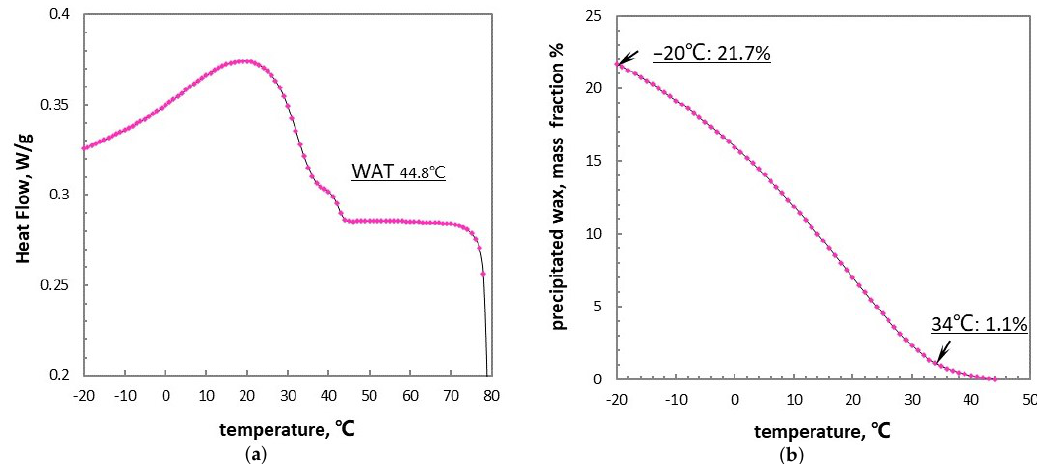
Figure 6. Differential Scanning Calorimetry (DSC) curves of the waxy crude oil obtained in laboratory: ( a ) heat flow varying with temperature T . ( b ) mass fraction of precipitated wax varying with temperature T